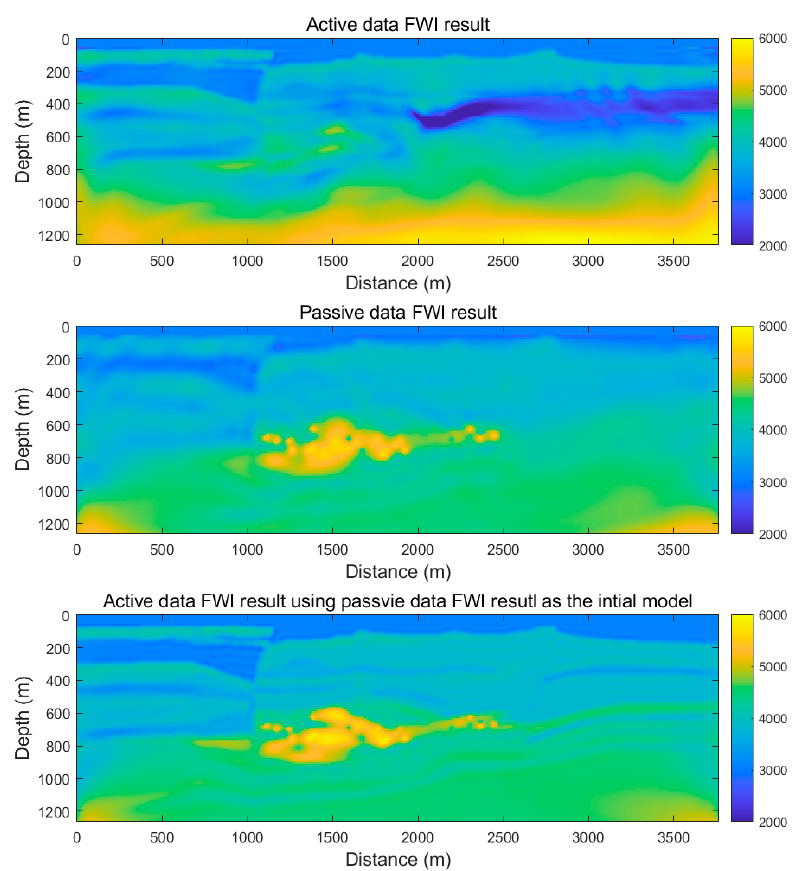
Figure 6. The results of numerical test one. The upper figure shows the FWI result only using the active dataset (dataset 1 in Table 2). The middle figure shows that the FWI result only uses the passive dataset (dataset 3 in Table 2). The lower figure shows the FWI result when using both active and passive datasets.